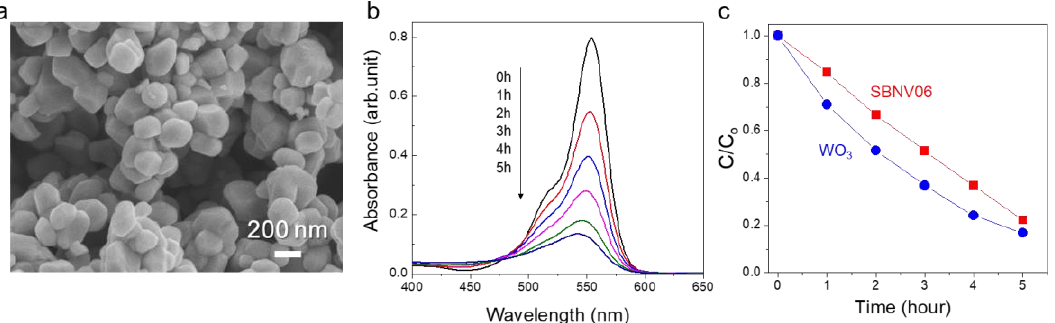
Figure 7. Comparison of VIS-induced photocatalytic activity between WO 3 and SBNV06, under VIS irradiation ( λ > 420 nm). ( a ) SEM image of the WO 3 powder. ( b ) Variation of the absorbance of RhB dye solution with time for the WO 3 . ( c ) Concentration change profiles with irradiation